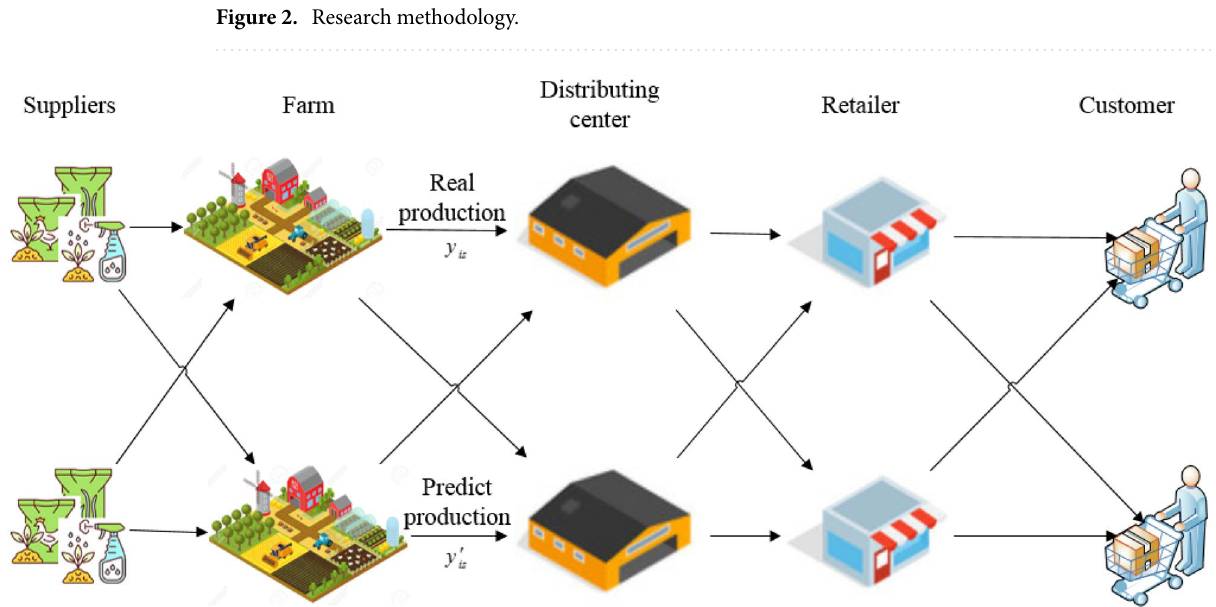
Figure 3. RRML for forecasting